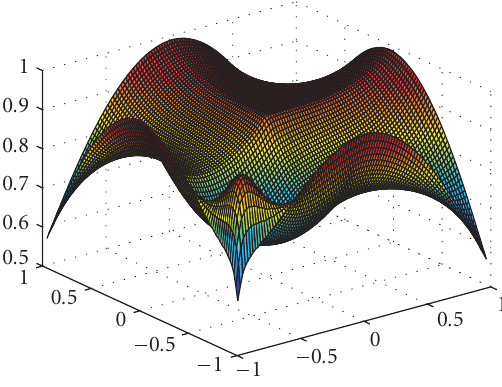
Figure 4.13 . Example 4.4: surface plot of discrete solution on a 50 × 50